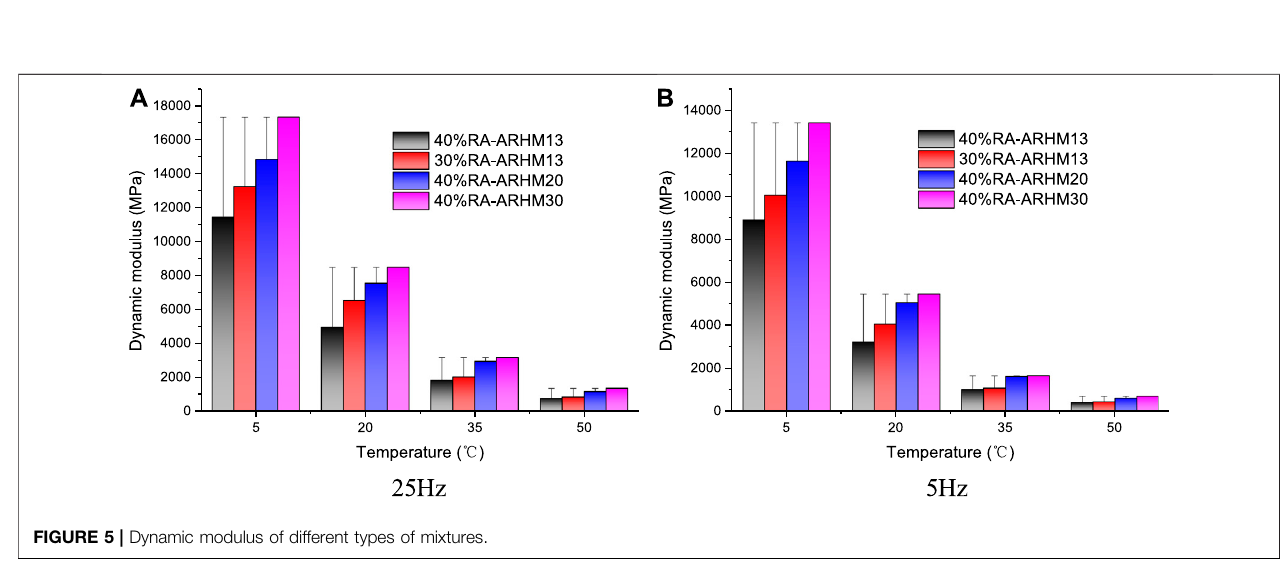
FIGURE 5 | Dynamic modulus of different types of mixtures.